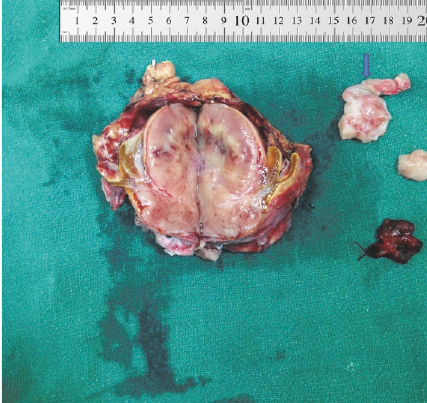
Figure 2: Pheochromocytoma in cut section with IVC thrombus (shown by